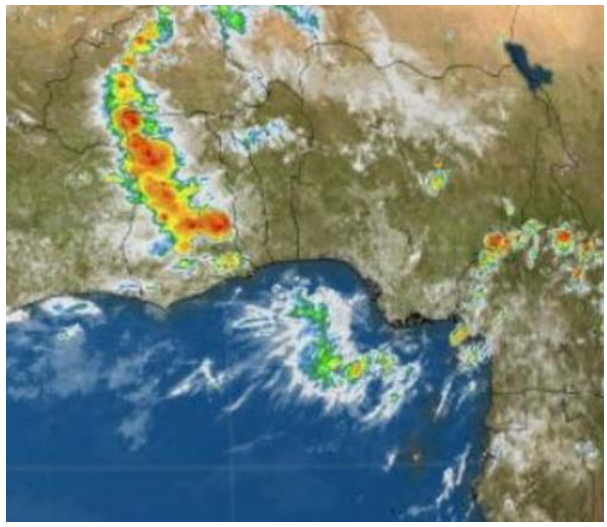
Figure 10. Bad weather conditions over part of the HFSWR surveillance area.